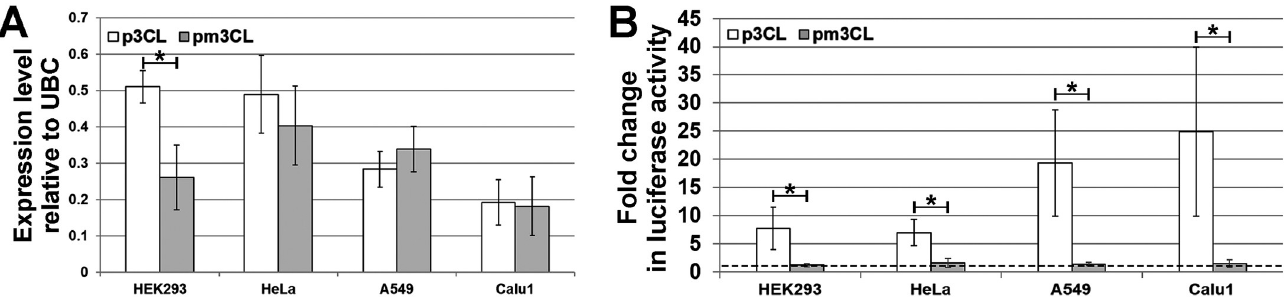
Fig 1. Analysis of the 3CLpro and m3CLpro mRNA expression and activity. HEK293, HeLa, A549, and Calu1 cells were transfected with p3CL or pm3CL plasmids. Total RNA was isolated 24 h post transfection and expression of target genes was detected using quantitative PCR with reverse transcription (A). Expression of 3CLpro and m3CLpro was normalized against ubiquitin C (UBC) reference gene and analyzed for each cell line used. Values are represented as mean ± SD of three independent measurements. The proteolytic activity of 3CL pro was assayed using GloSensor technology (B). Cells were co-transfected with pGlo-3CL and p3CL or pGlo-3CL and pm3CL constructs and 24 h p.t. luciferase activity in transfected cells was analyzed. Fold changes in luciferase activity relative to control cells, transfected with pGlo-3CL and pCI, after 20 min of incubation with GloSensor reagent are shown. Values are represented as mean ± SD of two independent experiments with triplicates (n =